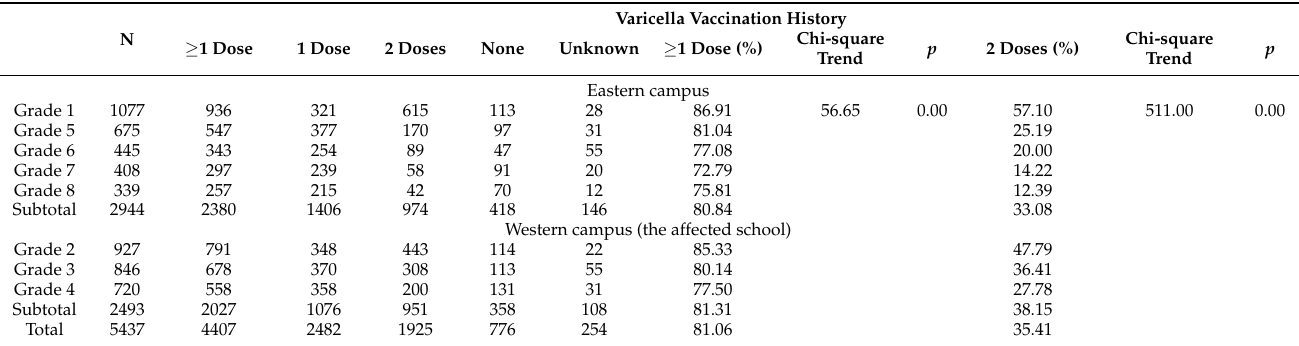
Table 1. Varicella vaccination coverage on the two campuses.